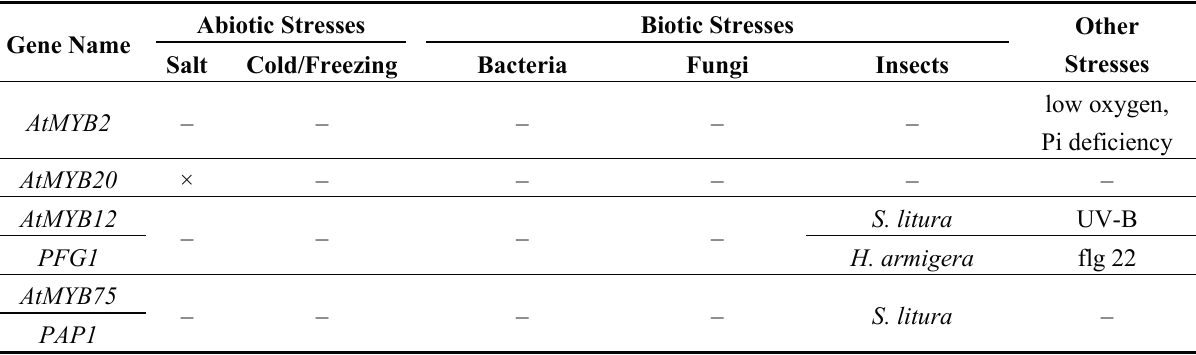
Table 2. MYB genes involved in crosstalk between drought and other stress responses. Flg 22: flagellin 22; HrpN: harpin protein; PEG: polyethylene glycol; Pi: Phosphate; TNV: tobacco necrosis